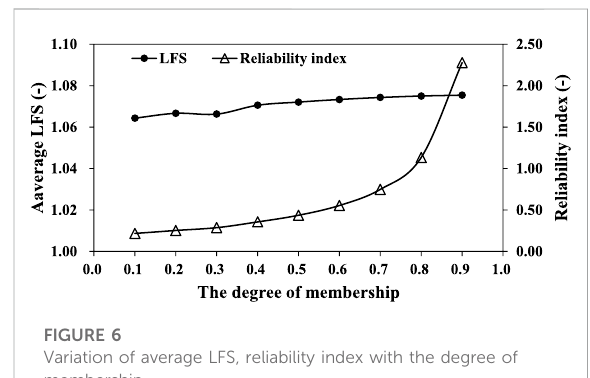
FIGURE 6 Variation of average LFS, reliability index with the degree of